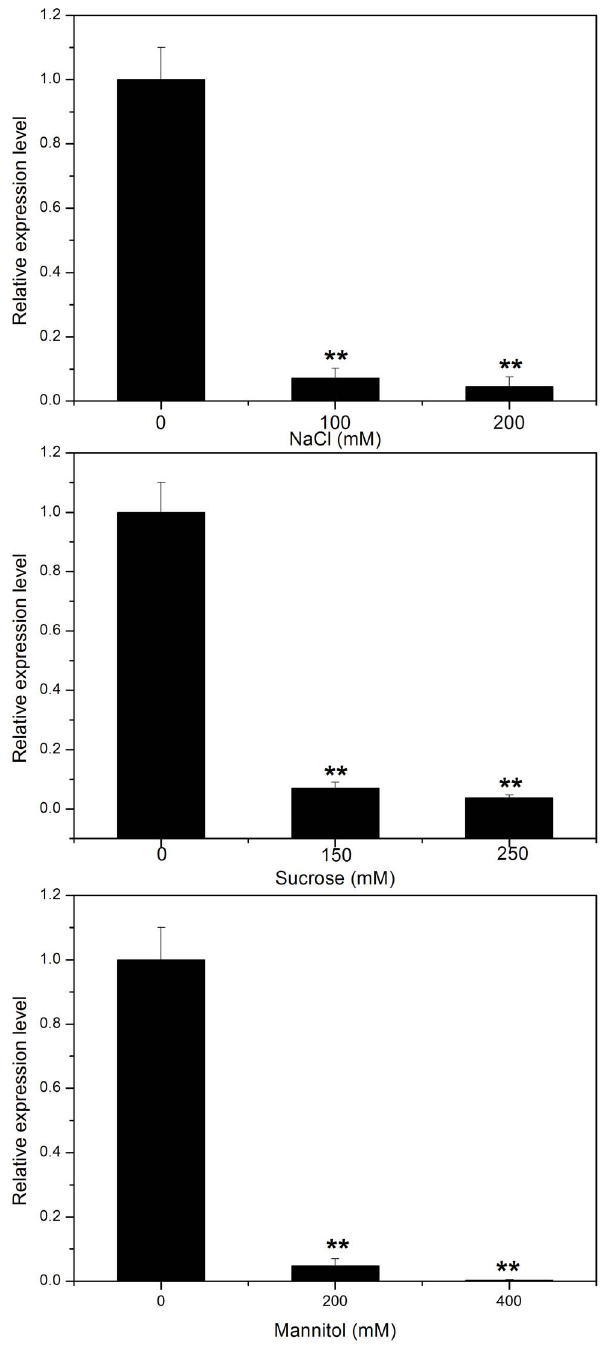
Figure 9. Expression of AtEXP2 in response to salt and osmotic stresses during seed germination. Col-0 seeds were collected 24 h after imbibition in different concentrations of NaCl, sucrose and mannitol. Error bars represent SD. A Student’s t-test was calculated at the probability of 1% (**P , 0.01).